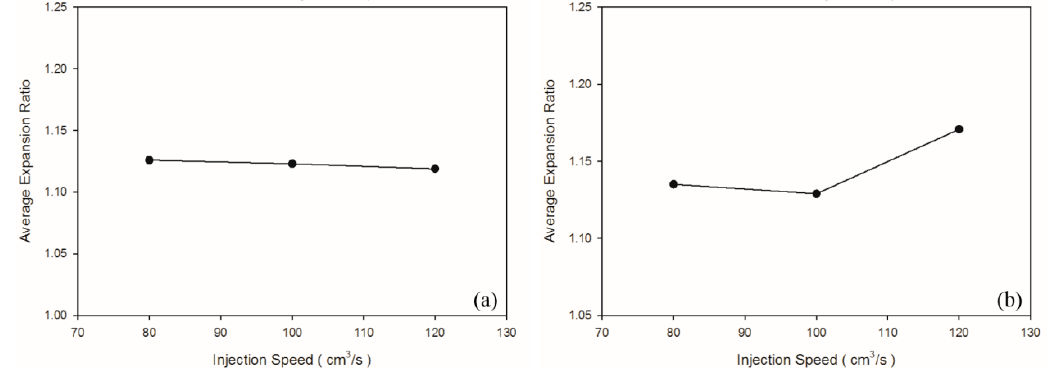
Polymers 2021 , 13 , x FOR PEER REVIEW Figure 6. Weights and specific weights at different injection speeds: ( a ) PP matrix and AC CBA; ( b ) PS matrix and AC CBA.